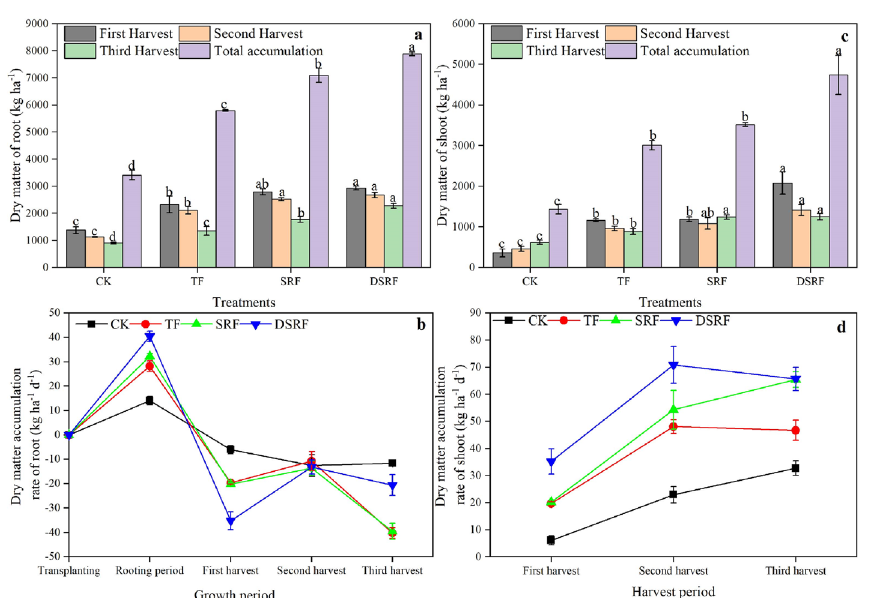
Figure 2. Dry matter accumulation of the roots ( a ), dry matter accumulation rate of the roots ( b ), dry matter accumulation of shoots ( c ), and dry matter accumulation rate of the shoots ( d ) of wintering Chinese chives as affected by different fertilizer treatments. Lowercase letters indicate significant differences among different fertilization treatments ( p < 0.05). CK no fertilizer, TF traditional fertilization, SRF traditional fertilization with slow-release fertilizer, DSRF decreased fertilization with slow-release